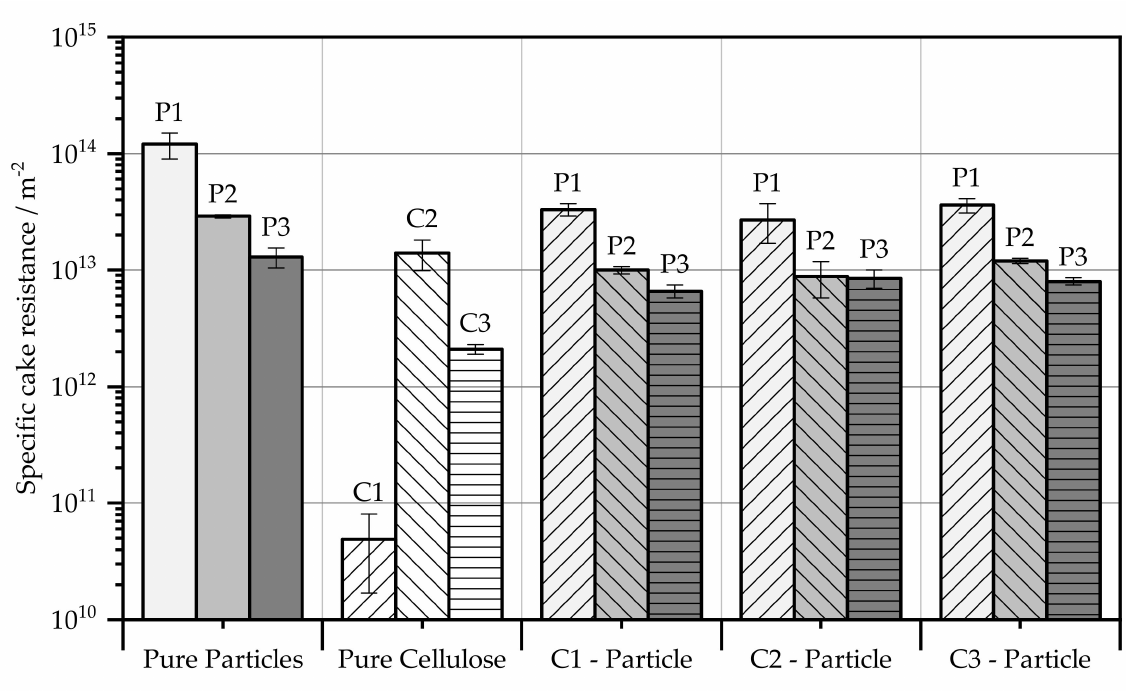
Figure 5. Filter cake resistances of the pure filter aids, particle systems, and their